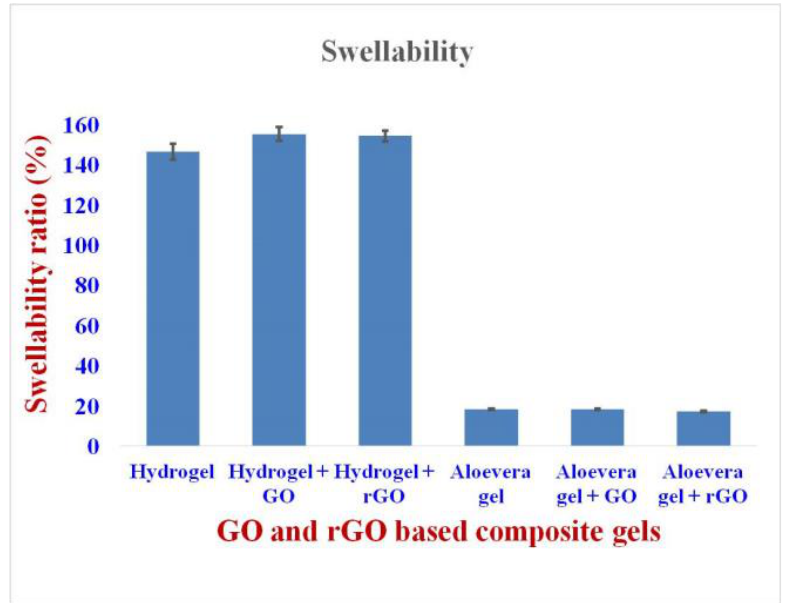
Figure 7. Swellability of GO and rGO-based composite gels. The hydrogel showed a swelling index of around 150%, whereas the aloe vera gel showed a very low swelling index of about 18%.